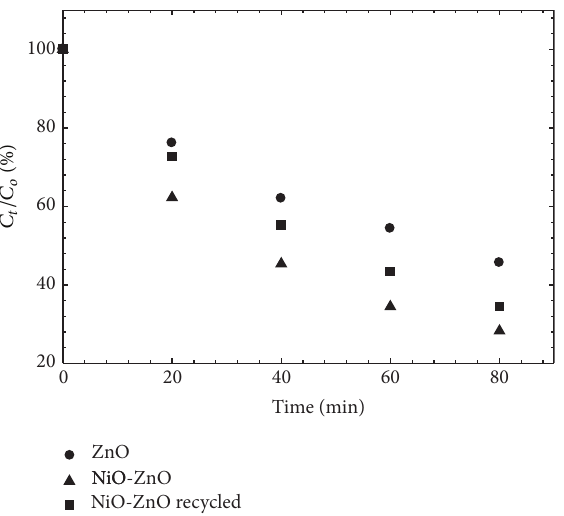
Figure 7: Relative amounts of methylene blue degraded versus time for ZnO NWs, NiO-ZnO NCs, and NiO-ZnO NCs